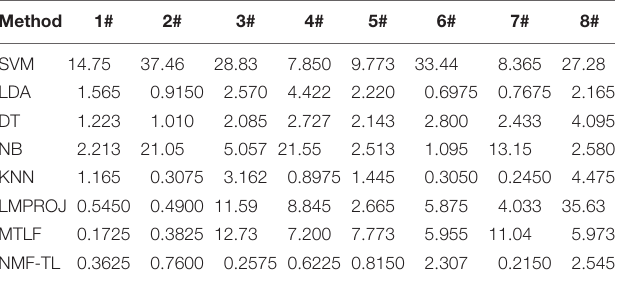
TABLE 14 | Friedman values for 8 different methods on datasets based on KPCA feature extraction. Method